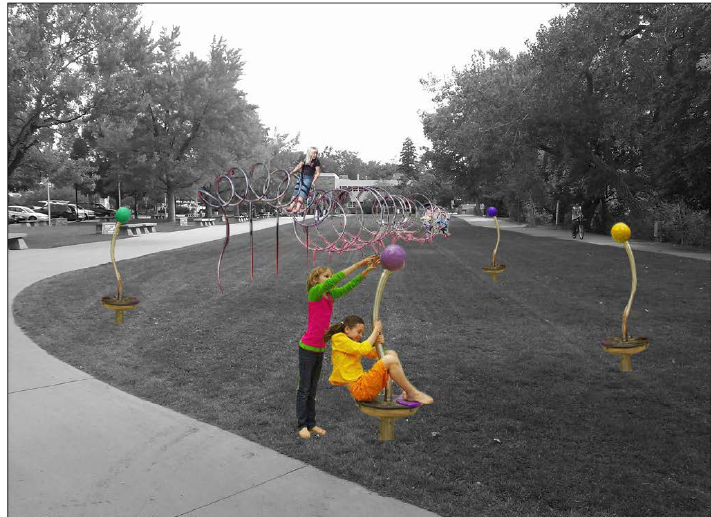
Figure 9. Rendering of student ideas for making the Civic Area more child- and youth-friendly. The green space currently exists, but the play structures do not (image courtesy of Ilaria Fiorini and Pier Luigi